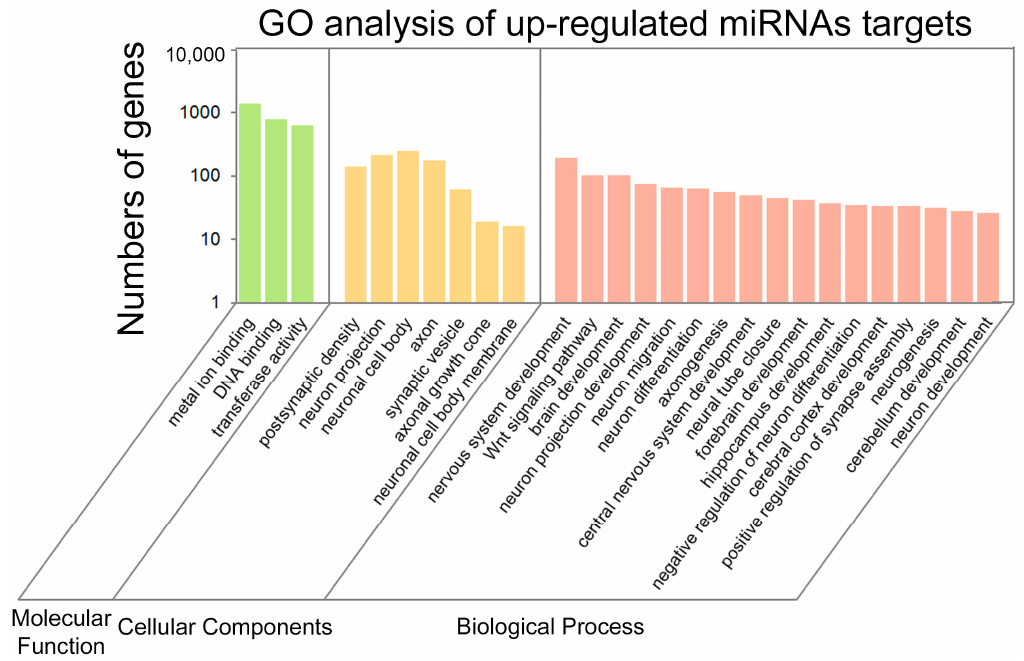
Figure 4. The histogram of target genes for up-regulated miRNAs in GO analysis.